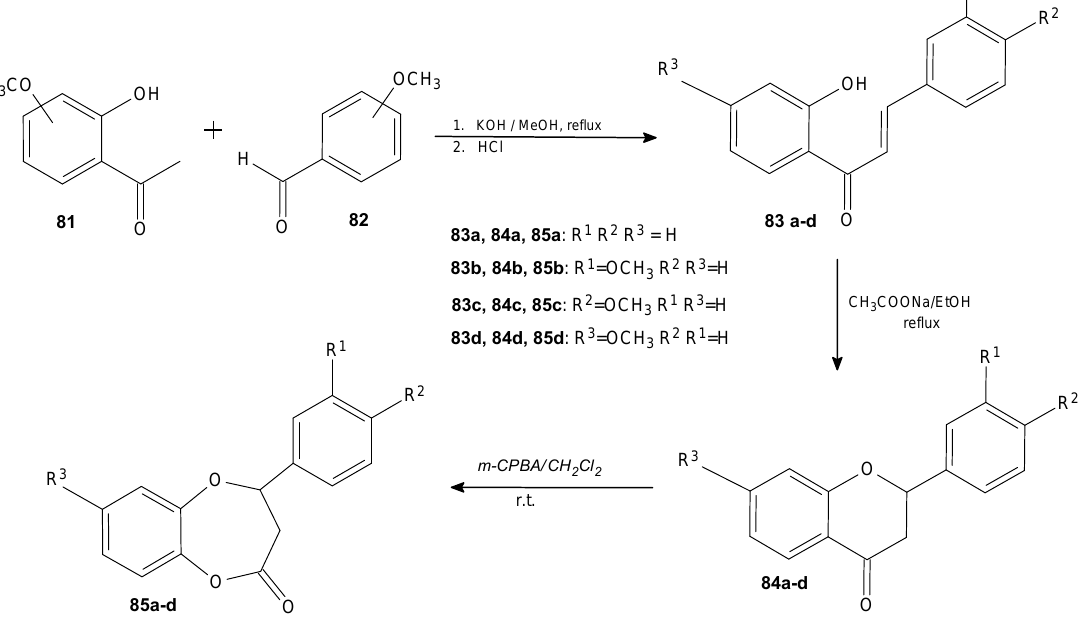
Figure 11. The synthesis of lactone 85a – d .